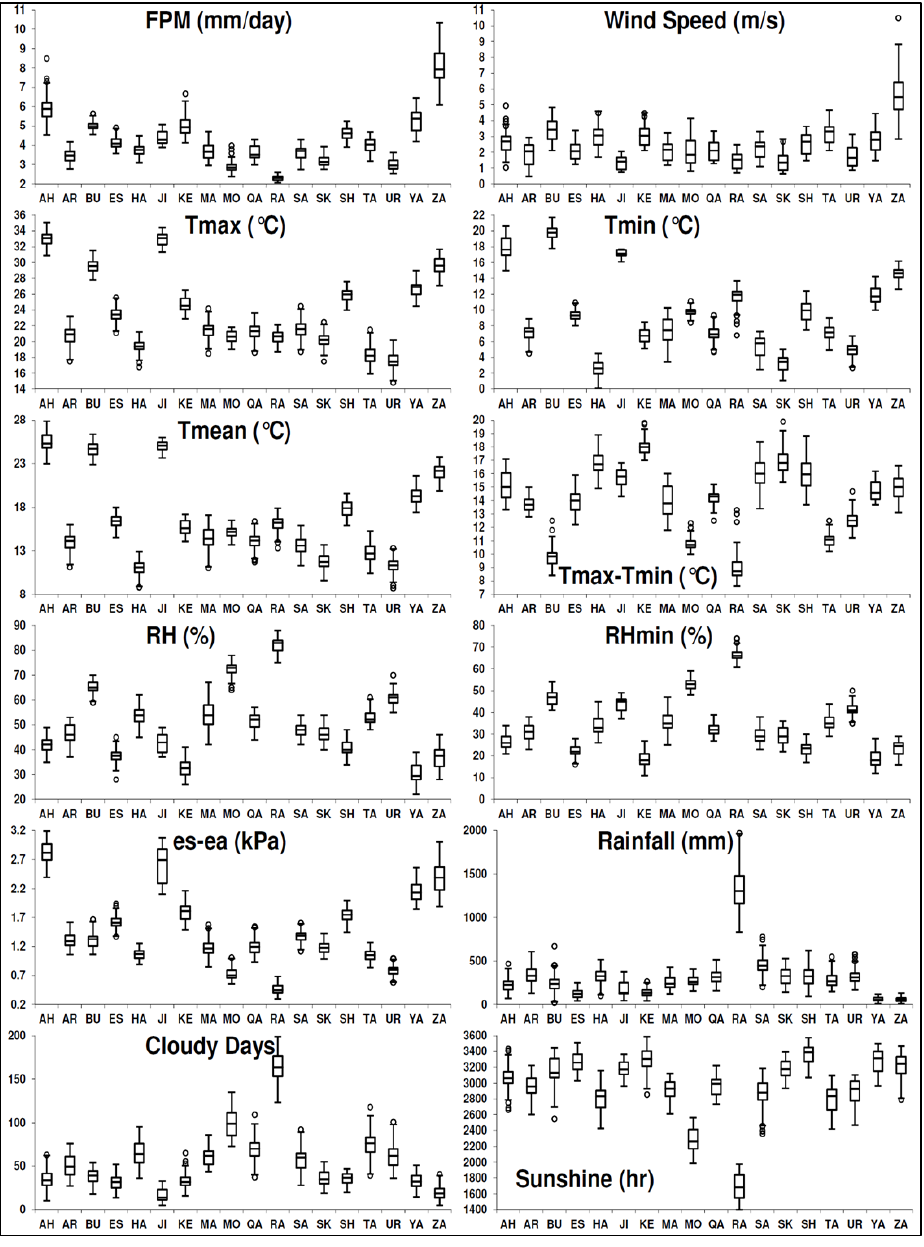
Figure 5. Statistical boxplots of meteorological variables and reference evapotranspiration in each study site. For each distribution, the horizontal line within the box indicates the median (50% percentile). The upper and lower edges of the box represent the 75% and 25% percentile, respectively. The upper and lower ends of the whiskers represent the maximum and minimum values. Outliers are observations beyond the end of whiskers.